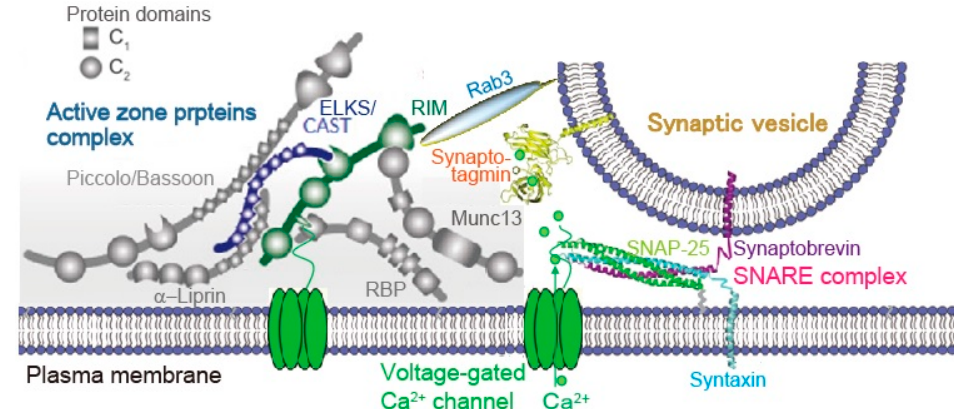
Figure 2. Active zone proteins. The active zone is a highly organized structure that docks synaptic vesicles (SVs) close to fusion machinery proteins (SNAREs) and Ca 2+ channels. This establishes the tight spatial organization required for fast exocytosis upon Ca 2+ entry, and it provides molecular machinery to set and regulate synaptic strength. Reproduced from Wang S et al., 2016 [26].